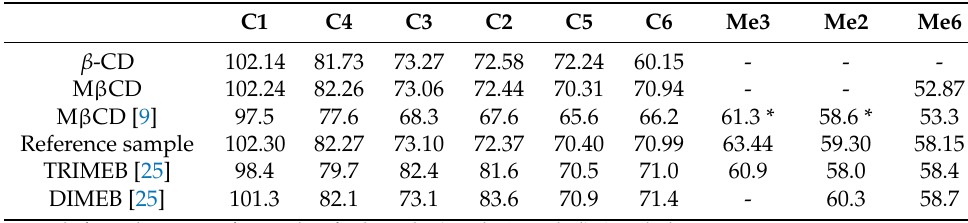
Table 2. 13 C-NMR chemical shifts for β -CD and methylated β -CD in DMSO-d6.